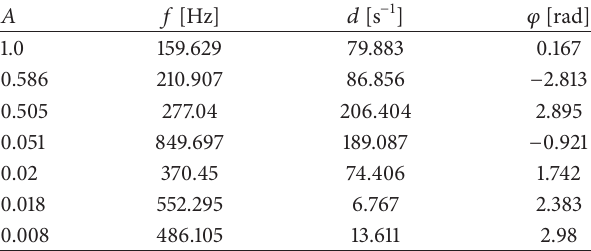
Table 2: Parameters of all EDS extracted by the MPM algorithm from the tympanic percussion signal of Figure